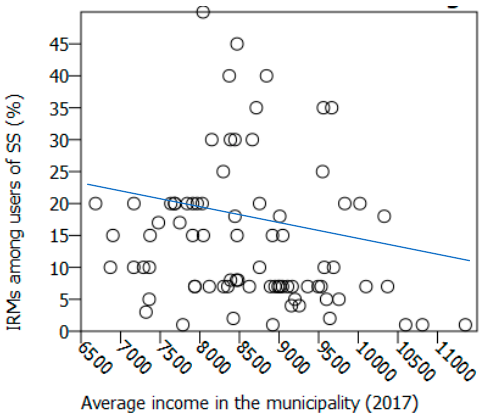
Figure 6. Use of Social Services by retirement migrants and average income of the municipality. Each dot is a municipality. The line is the regression line for a linear regression model with the two variables.